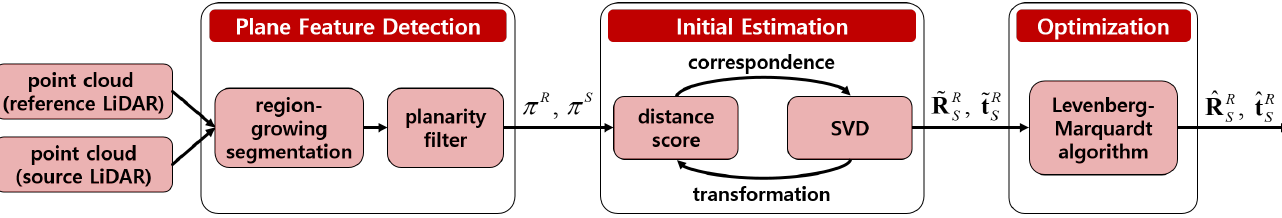
Figure 2. An outline of the proposed method. The calibration first performs a plane feature detection process for segmenting a point cloud and detecting plane objects. After that, an initial estimation of extrinsic parameters is performed through an iterative plane registration. The primary purpose of initial estimation is to find the right corresponding planes. Finally, the extrinsic parameters are refined through optimization using the measurement points within the corresponding